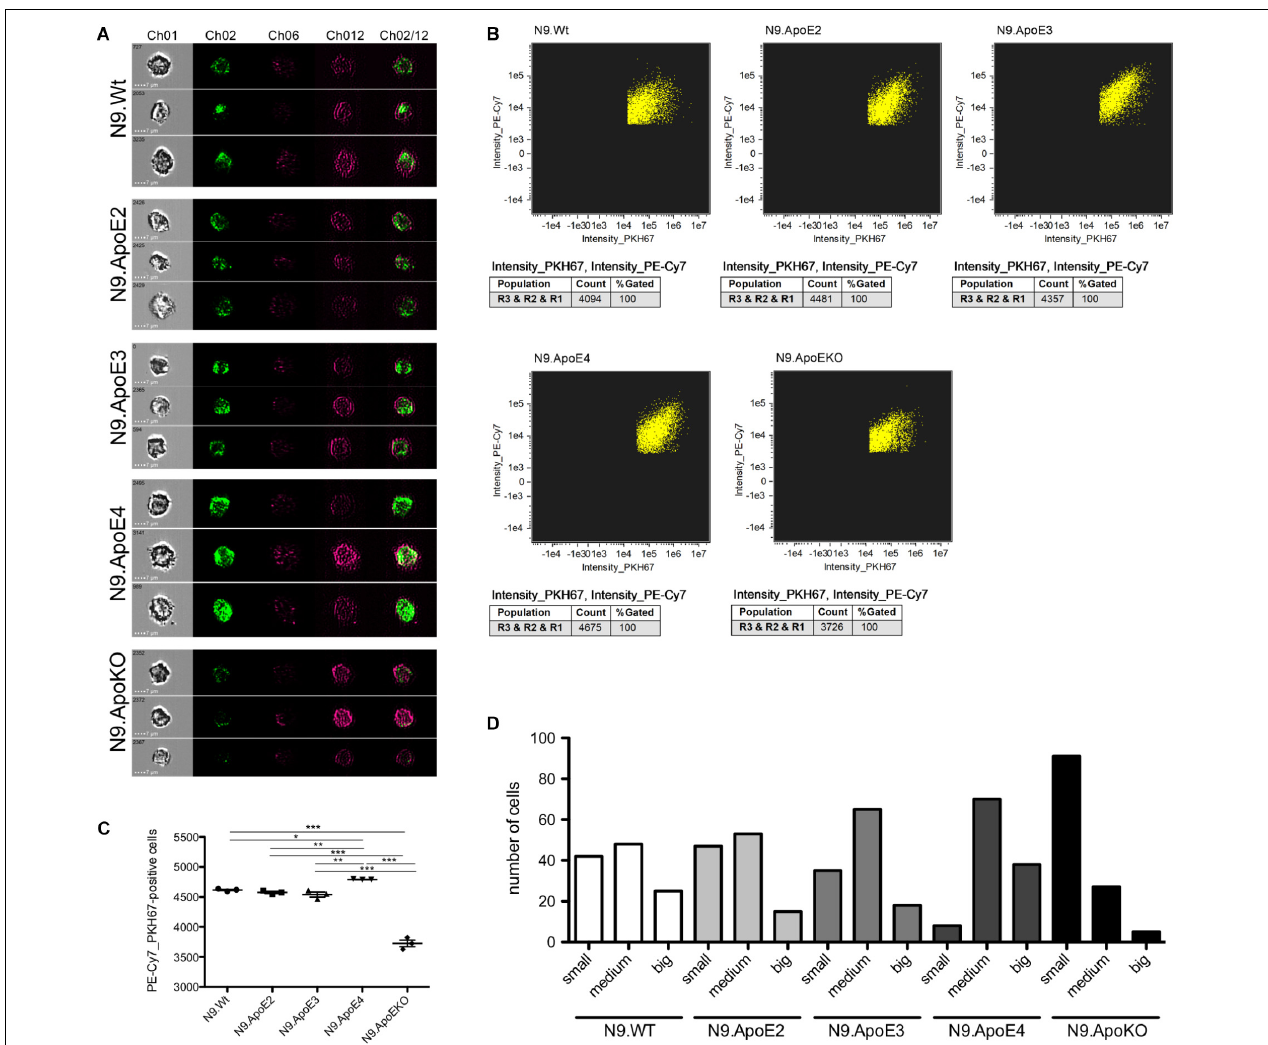
FIGURE 5 | Microglia phagocytosis of apoptotic N2a-cells is upregulated in N9.ApoE4 cells in vitro . (A) Representative pictures of imaging flow cytometry (Image Stream Mark II, Merk) of N9-cells (purple) after phagocytosis of labeled UV-treated neurons (green). Ch01: brightfield; Ch02: PKH67 (UV-treated N2a cells, apoptotic); Ch06: side scatter; Ch12: PE-Cy7-anti-CD11b (N9-cells); Ch02/12: overlay of Ch02 and Ch12. The images demonstrate the significantly upregulated phagocytosis by N9.ApoE4 in comparison to N9.Wt. Cells with ApoE knockout show a significant decrease in phagocytosing apoptotic cells or debris [a total of 45.000 cells was analyzed in n = 3 (including each three technical replicates of 5000 cells)]. (B) Gating of PKH67 + PE-Cy7 + N9 cells was done with AMARIS software. (C) 5.000 N9 cells of each group were quantified with AMARIS and Prism software. (D) Quantification of the amount and size of phagocytosed fragments/cells was done manually (small: < ∼ 3.5 µ m; medium: ∼ 3.5–7 µ m; big: > ∼ 7 µ m). N9.ApoE4 phagocytose more and bigger fragments than N9.Wt and N9.ApoEKO ( n = 100 cells). Statistical significance was set up at ∗ p < 0.05, ∗∗ p < 0.01, and ∗∗∗ p <